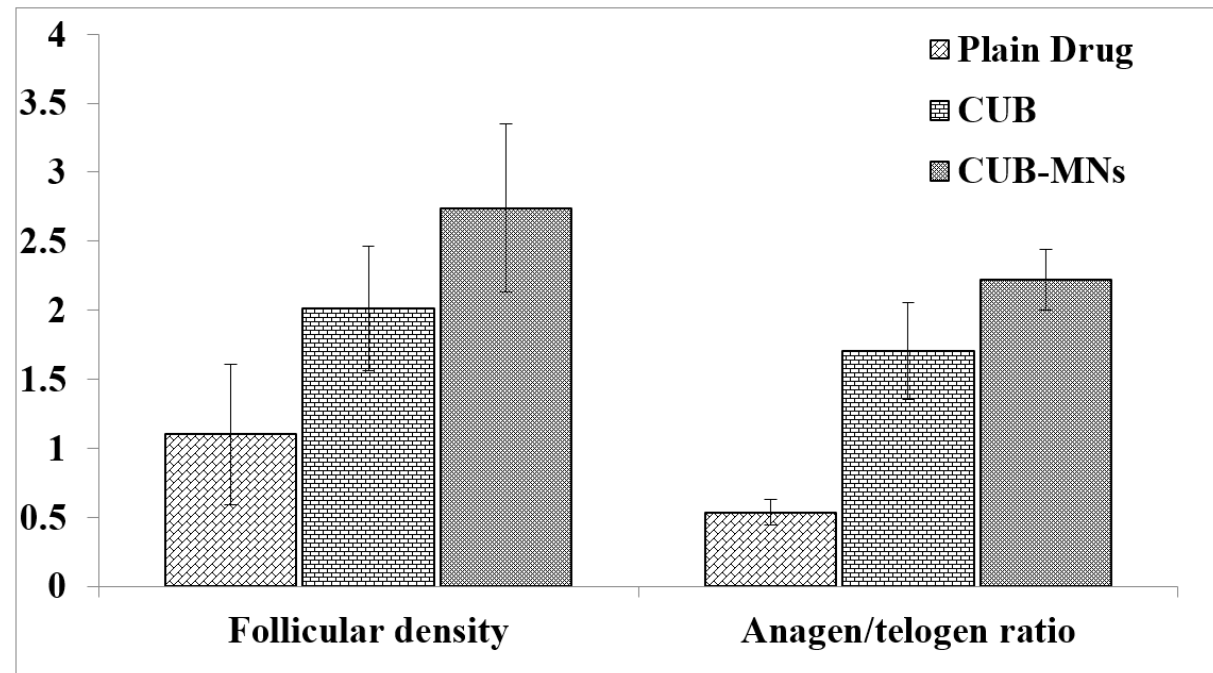
Figure 8. Hair growth pattern in CUB-MN D -treated groups was comparable to that for the β -ST- loaded CUB and plain drug